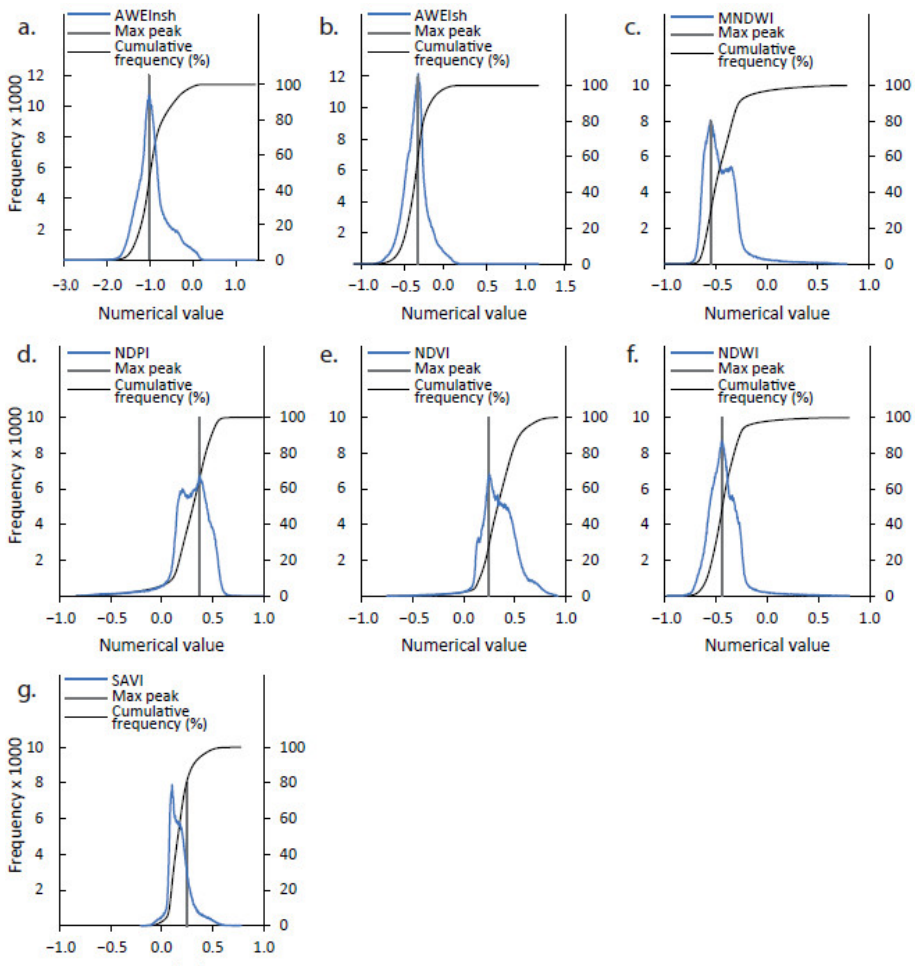
Agronomy 2022 , 12 , x FOR PEER REVIEW 12 of 20